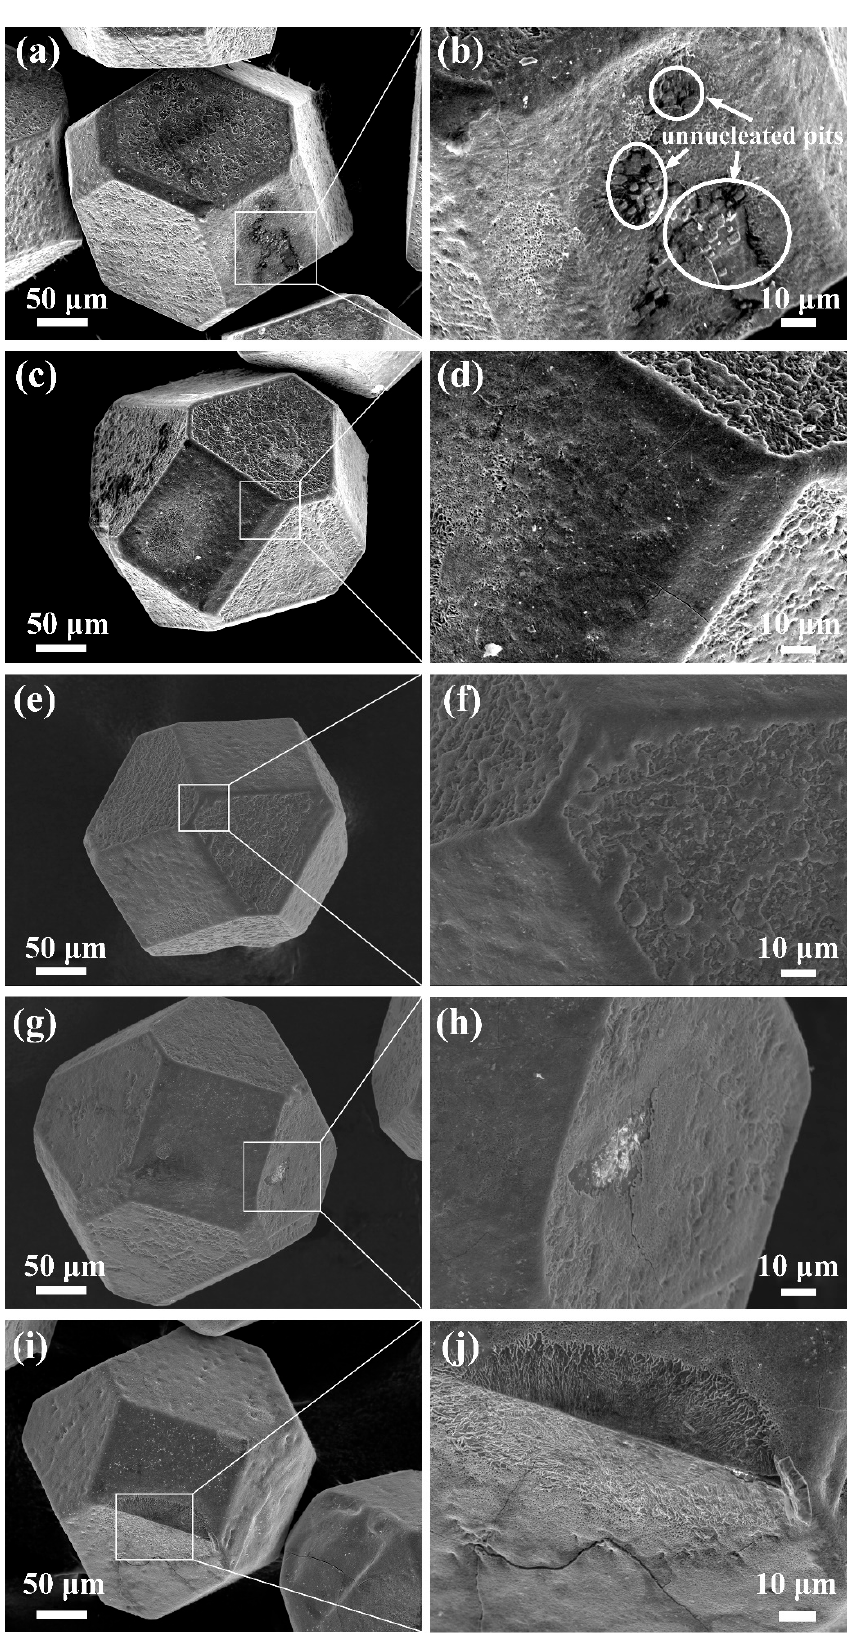
Figure 1. Cr coating diamond surface morphology under salt bath process with different parame- ters: ( a , b ) 950 °C/30 min, ( c , d ) 950 °C/60 min, ( e , f ) 950 °C/90 min, ( g , h ) 1000 °C/30 min, and ( i , j ) 1050 °C/30 min.